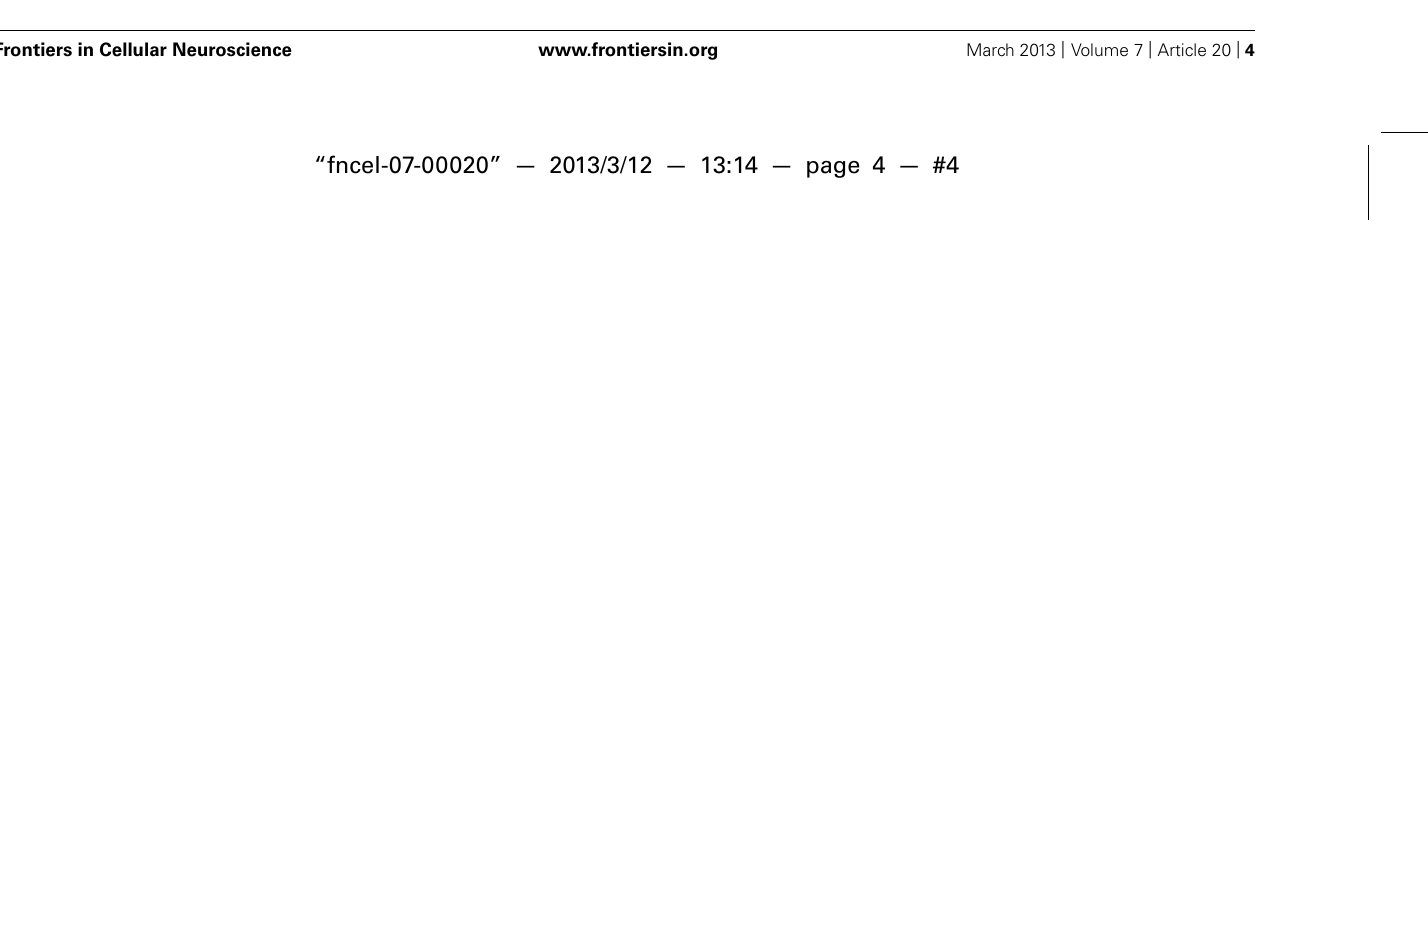
FIGURE 1 | Effects of the GABA(A) receptor agonist isoguvacine on neuronal activity in the intact in vitro hippocampus during the first post-natal week. (A) Example recordings of extracellular MUA responses to isoguvacine application (10 μ ì, marked with a bar) in a CA3 pyramidal cell layer of P1 and P6 intact mice hippocampi in vitro . Concomitant whole-cell voltage clamp recordings from a putative CA3 pyramidal cell are also shown for P1 intact hippocampus above the MUA trace. GDPs are labeled with asterisks. One event before and several events during isoguvacine application are given